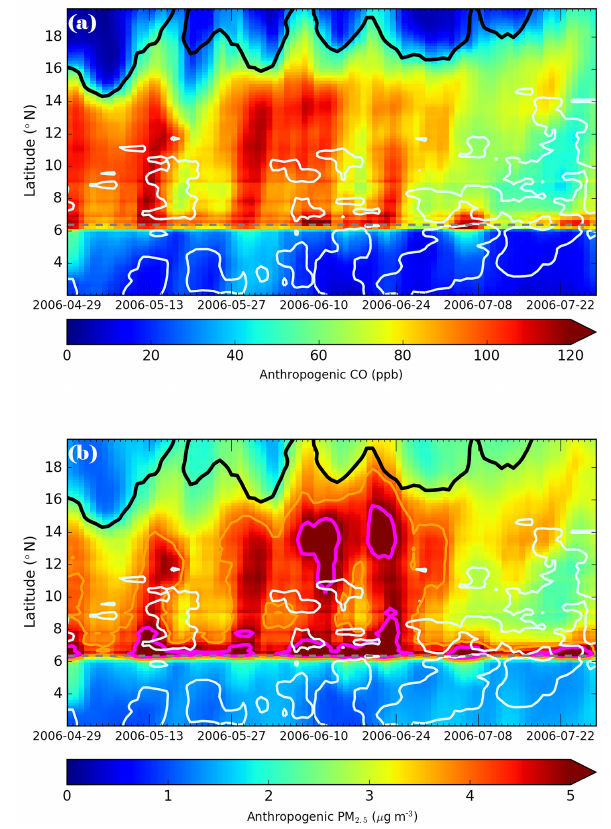
Figure 5. Time–latitude average (Hovmöller diagram) of (a) sur- face CO concentration (ppb) and (b) PM 2 . 5 (µgm − 3 ) due to an- thropogenic emissions along a meridional transect from 2 to 19 ◦ N and averaged from 2 to 3 ◦ E including Cotonou (Benin) and Ni- amey (Niger). Day-to-day variability is smoothed by applying a moving average of ± 2 days. White contours are precipitation of 10mmday − 1 . Specific isocontours are highlighted: 4µgm − 3 (or- ange) and 5µgm − 3 (violet). The black line is the ITD defined as RH isocontour of